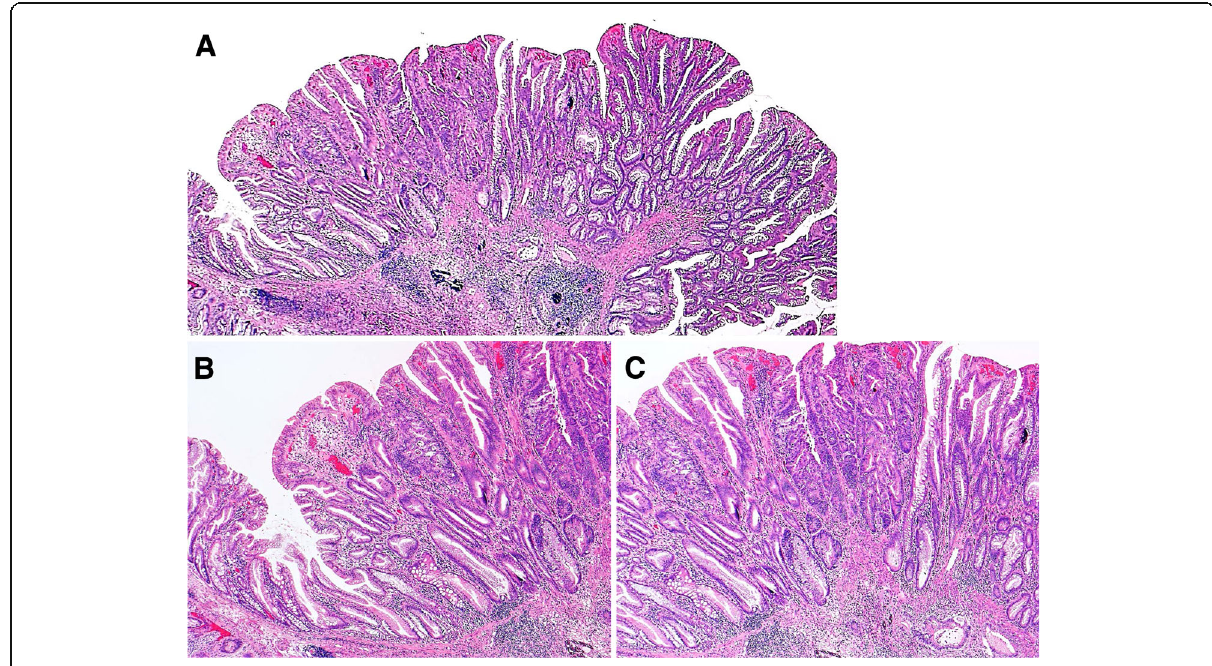
Fig. 1 Typical morphologies in a representative case of sessile serrated adenoma/polyp (SSA/P) with submucosal carcinoma (Case #6). a Dilated crypts with deep serration was seen on both sides of the lesion, and high-grade dysplasia with submucosal invasion was seen in the middle. b High-power field of ( a ) (the left side). Crypts with a serrated architecture included those that were irregularly dilated, irregularly branched, and horizontally arranged (basal), corresponding to SSA/P. c High-power field of ( a ) (the middle). Well-differentiated tubular adenocarcinoma was observed invading the submucosa. Adjacent SSA/P areas were observed towards both sides of the panel. An abrupt transition was evident between the 2 adjacent